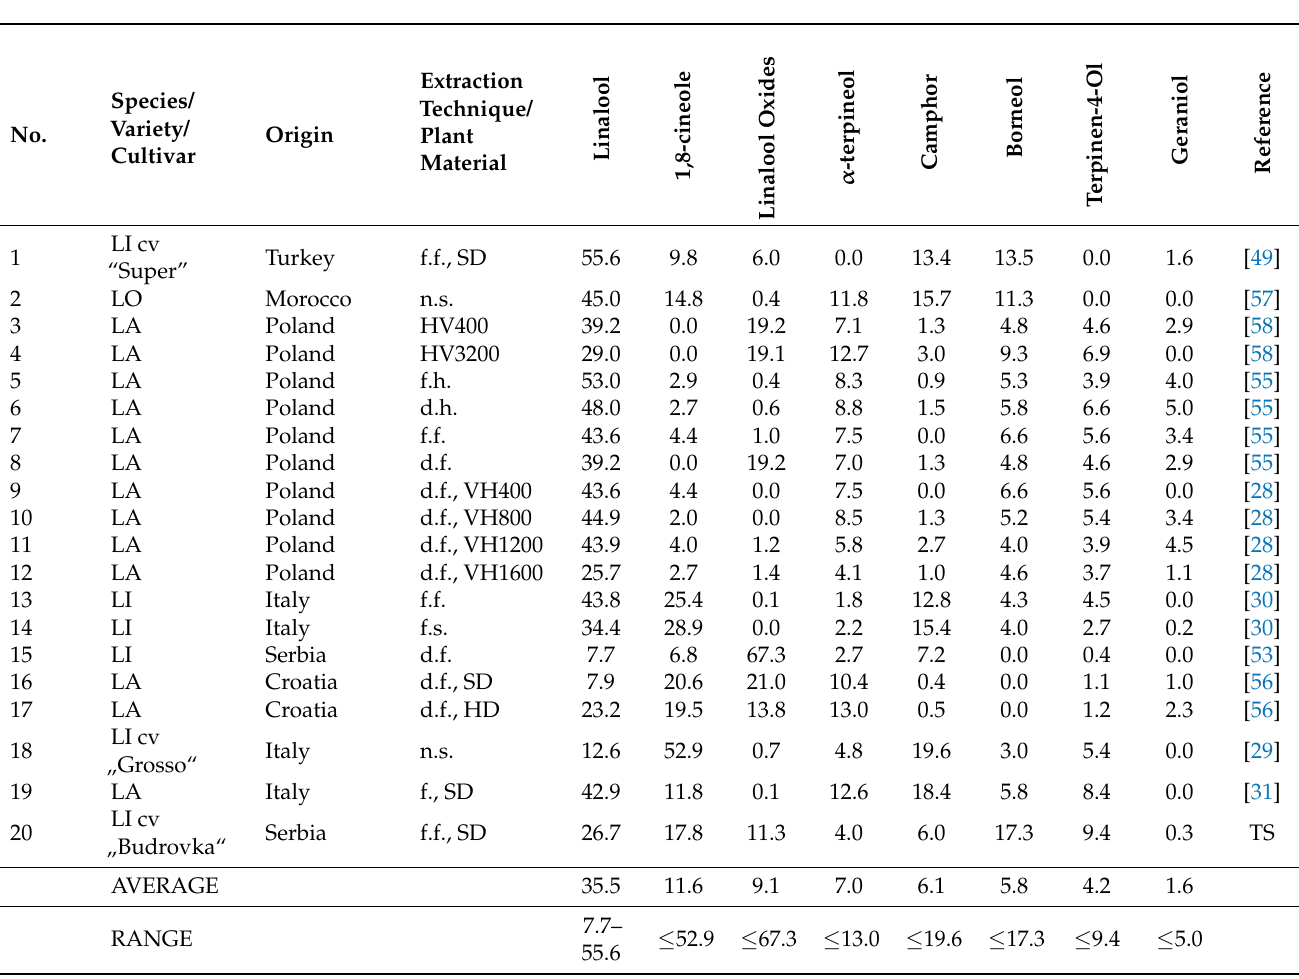
Table 7. Chemical composition of different Lavandula sp. hydrolates according to literature and this